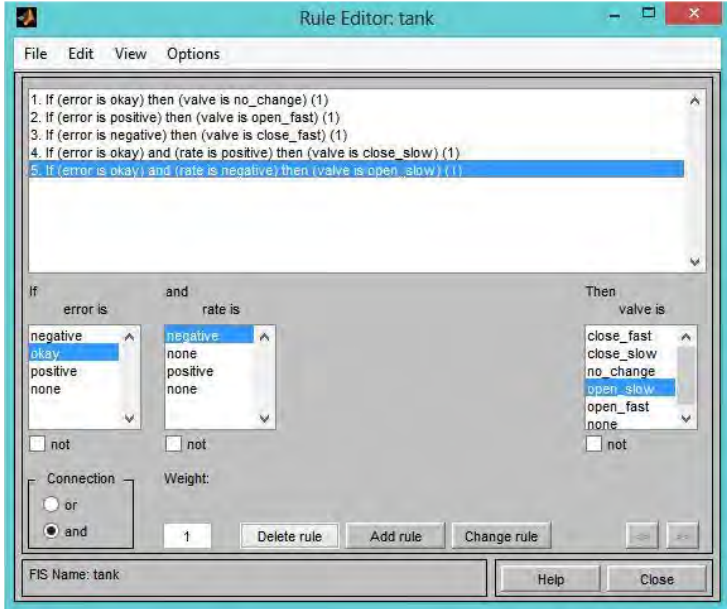
Figure 12. Fuzzy rules